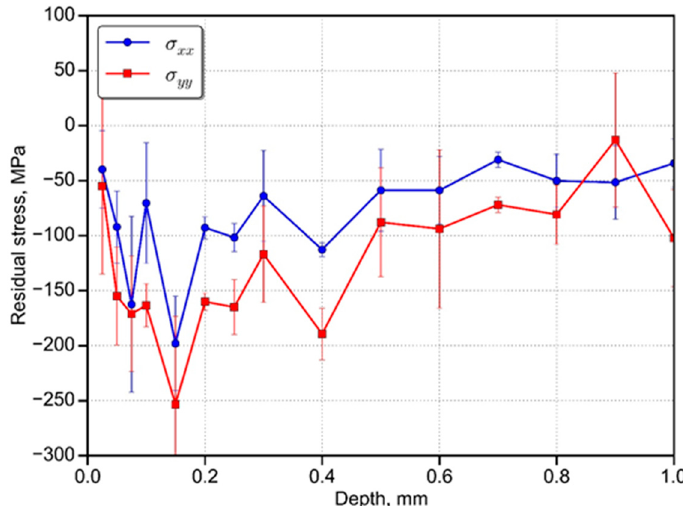
Figure 2. The residual stress distribution in an ARMCO iron sample after LSP. The x -axis ( σ xx ) is parallel to the length of the specimen for the fatigue test in Figure 1.